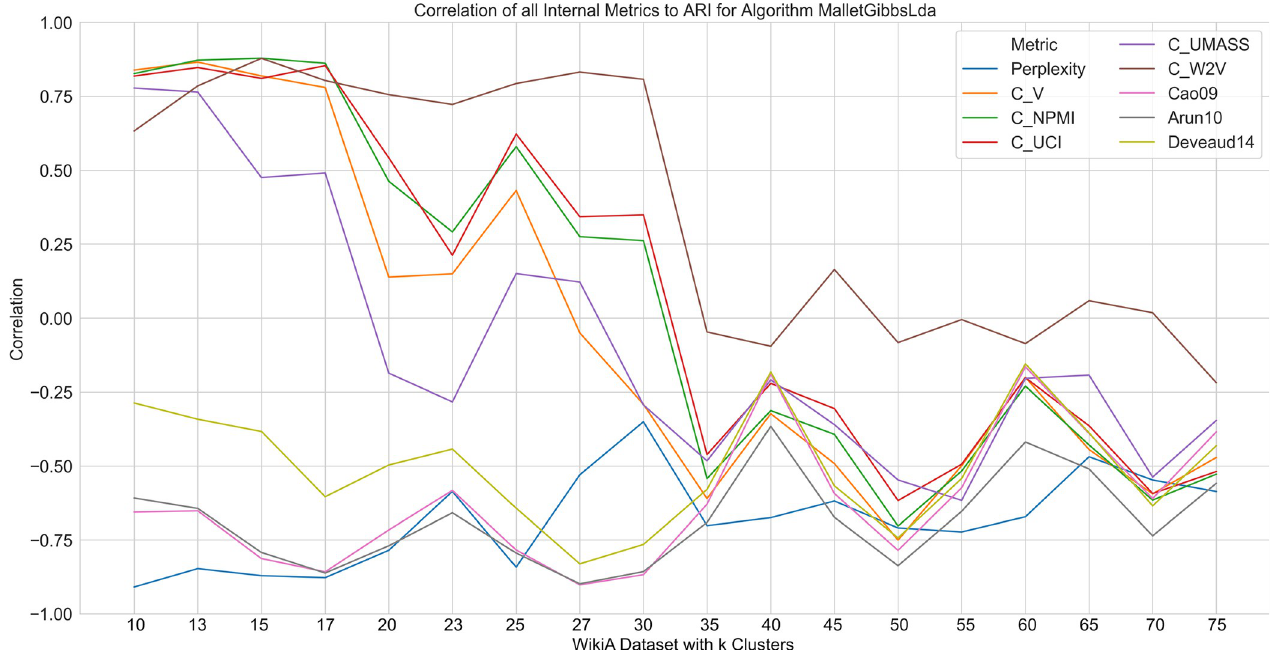
Fig 7. Correlation of all internal metrics to ARI of sampling-based LDA on the WikiA dataset series.